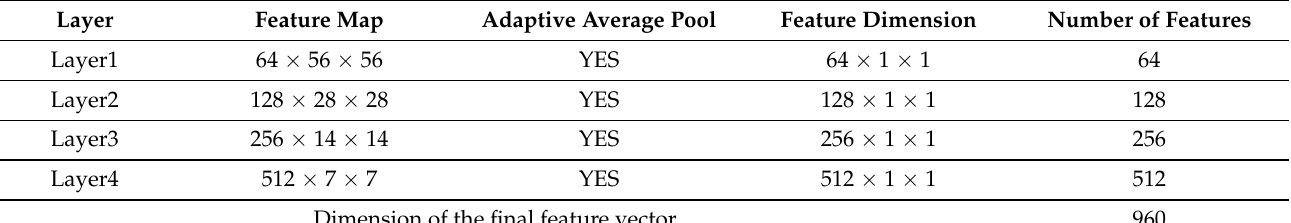
Table 1. Features extracted from different layers of ResNet18 network. Layer Feature